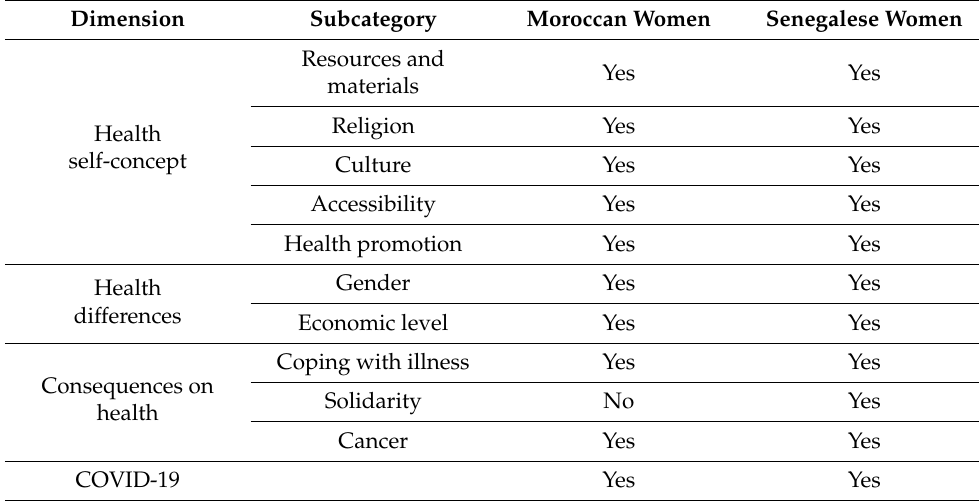
Table 4. Origin of categories and subcategories by population